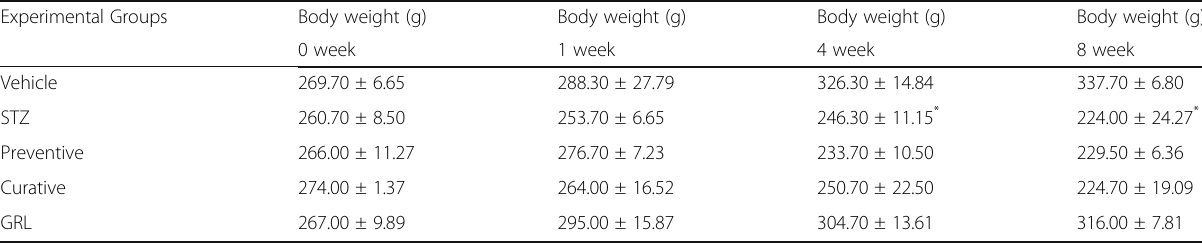
Table 2 Effect of the Juglans regia L. (GRL) leaf extract on body weight Experimental